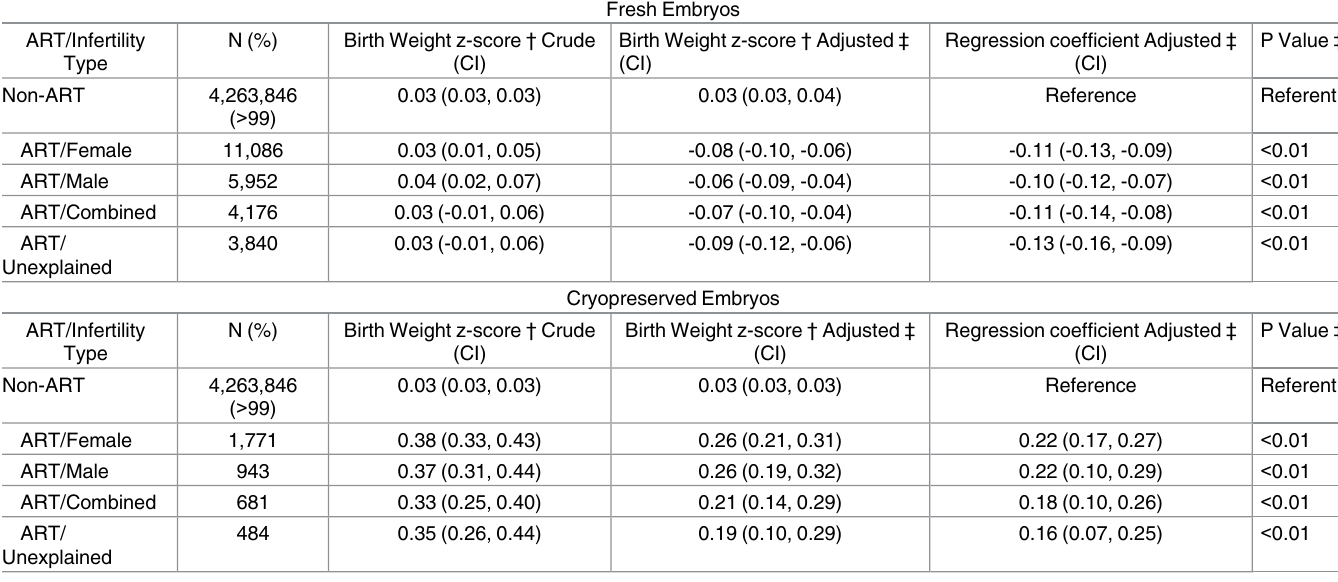
Table 4. Associations between birth weight z-score and ART singletons born following fresh or cryopreserved embryos transfer,using non-ART as the referent group. Population-based data of all singletonlive births in Florida and Massachusetts 2000–2010 and